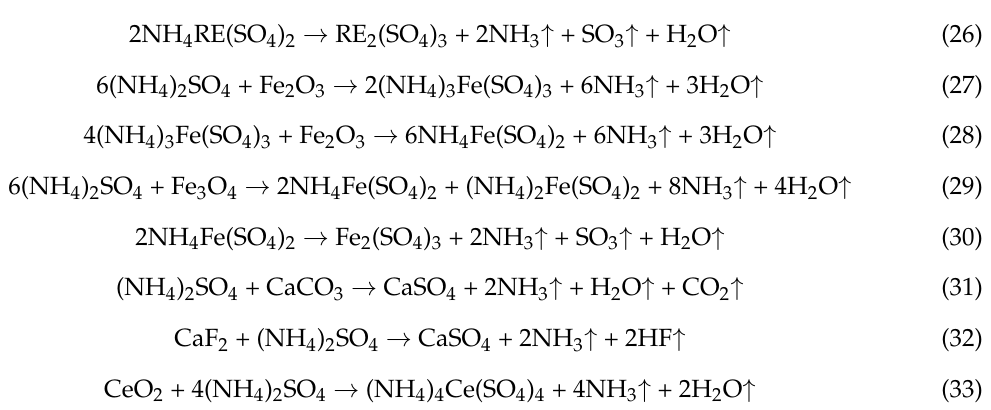
Figure 14. XRD patterns of (NH 4 ) 2 SO 4 activation roasting products at different temperatures: (a) 300 °C; (b) 350 °C; (c) 400 °C; (d) 450 °C; (e) 500 °C.